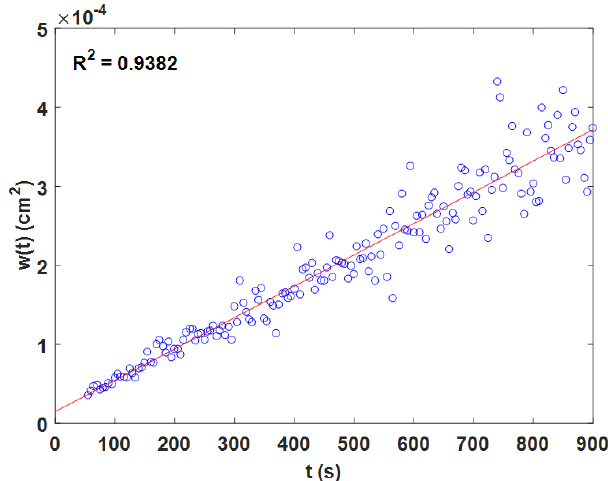
Figure 4. Plot of w versus time for rhodamine 6G in a 76wt% sucrose solution ( a w = 0 . 75). The red line is a linear fit to the data. The diffusion coefficient was determined from the slope of the